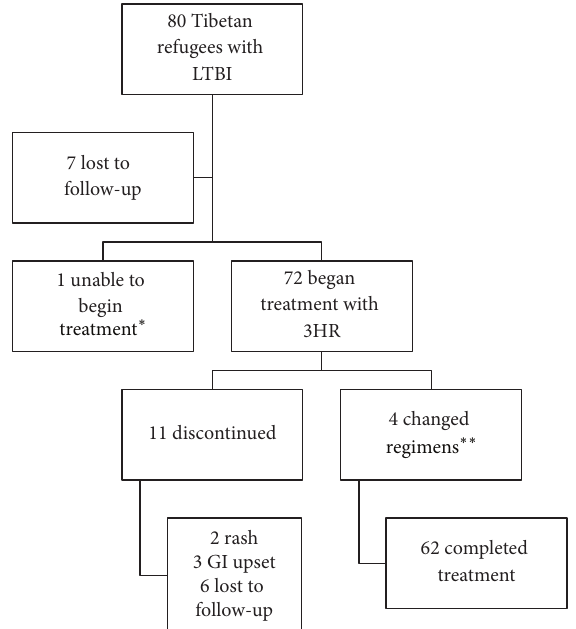
Figure 2: LTBI treatment between 2014 and 2016. 3HR = rifampin and isoniazid for three months. ∗ Due to elevated liver enzymes. ∗∗ Alternate regimens were either rifampin for four months or isoniazid for nine